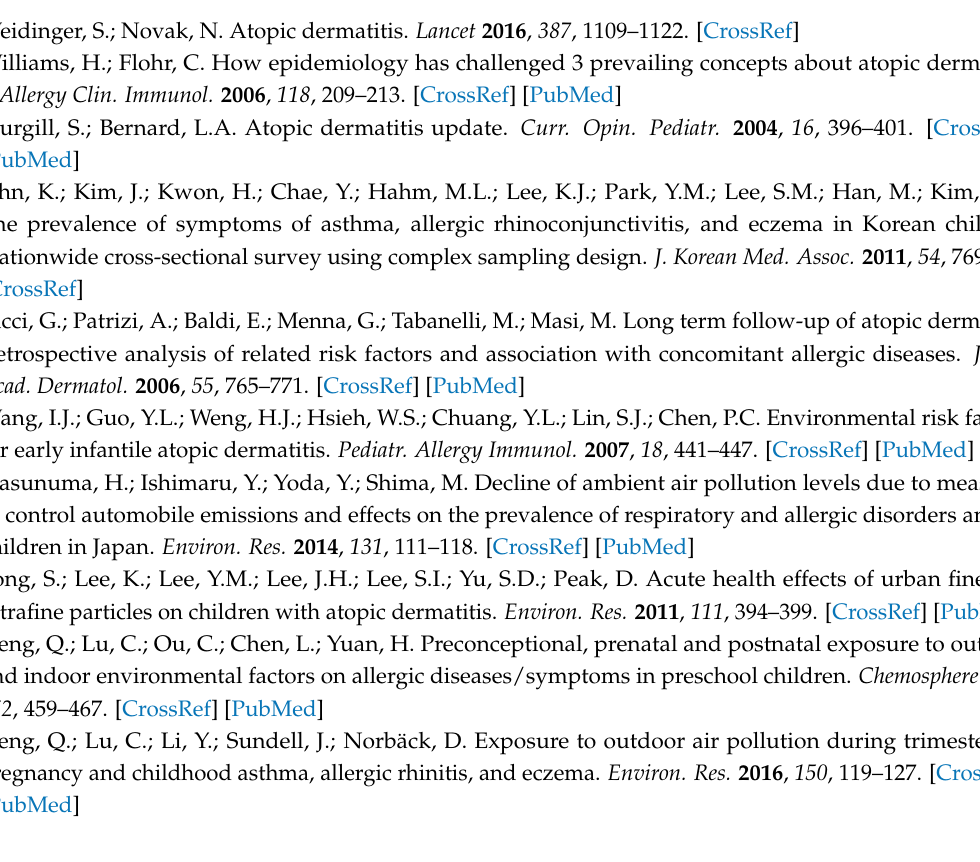
Table S1: Characteristics of study participants who were included or not included in the present